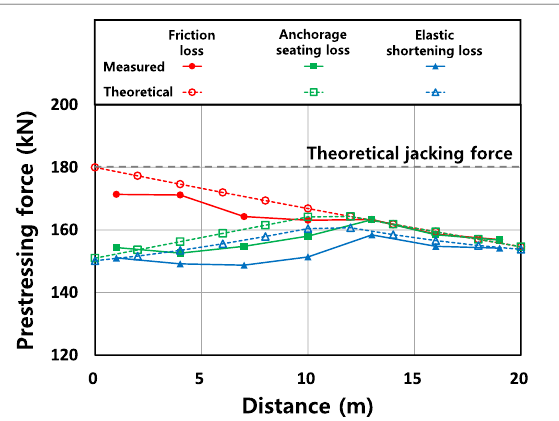
Fig. 9 PF distribution in girder 1 of bridge